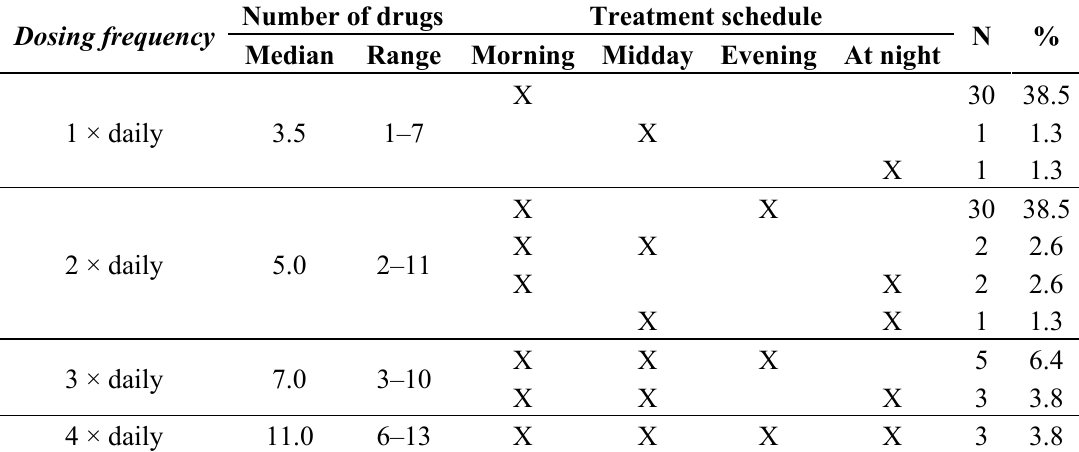
Table 1. Therapy plan characteristics for n = 78 patients with full sets of data. Dosing